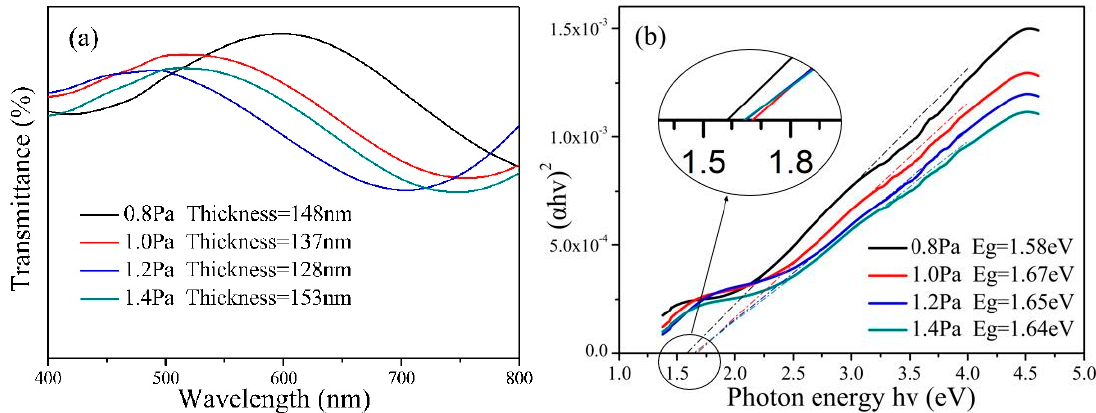
Figure 5. ( a ) Transmittance spectra of the MoS 2 films. ( b ) Relationship between ( ∂ hv ) 2 and hv of the MoS 2 films.